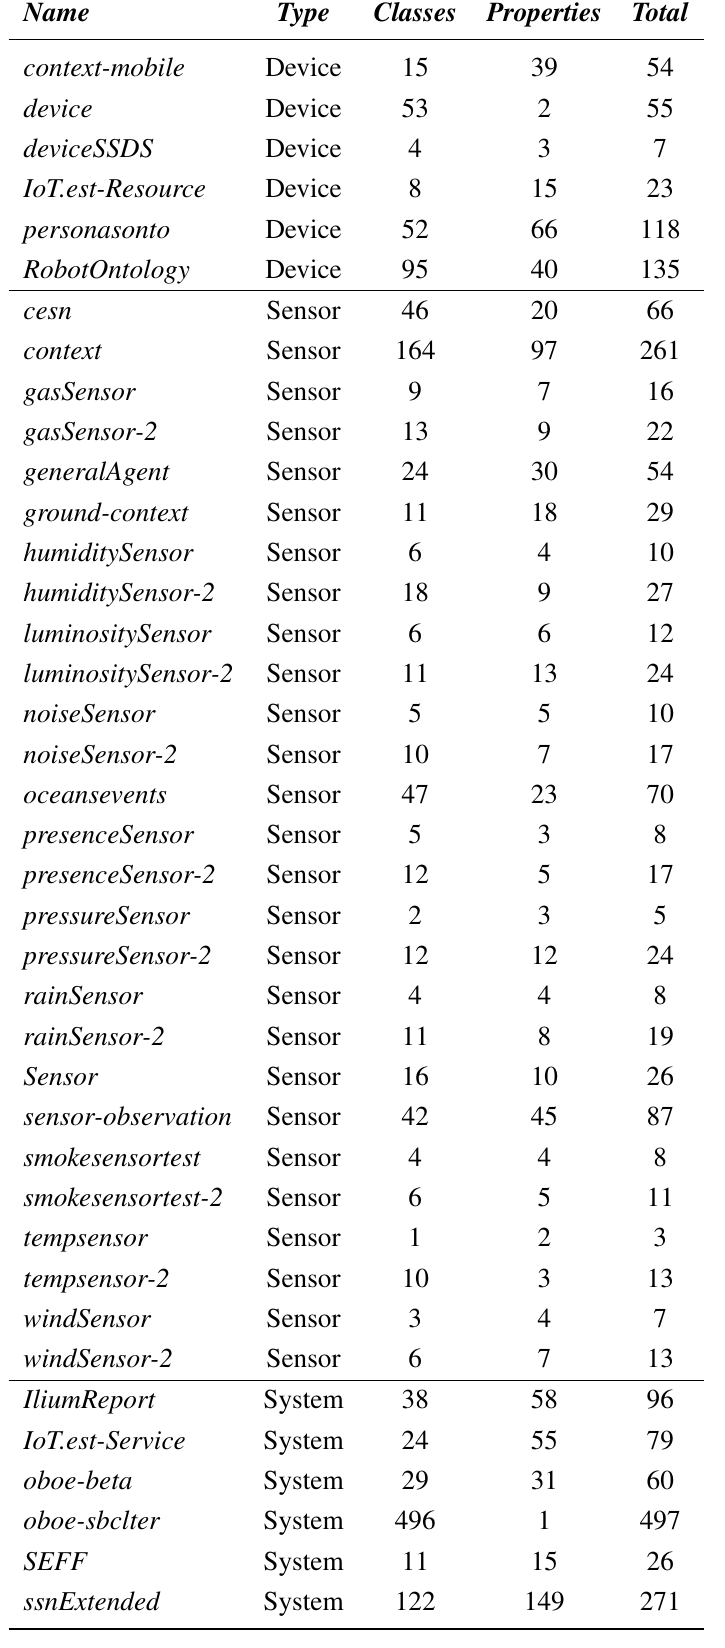
Table 4. General information about the agents’ ontologies used for the experiments with SOFIA